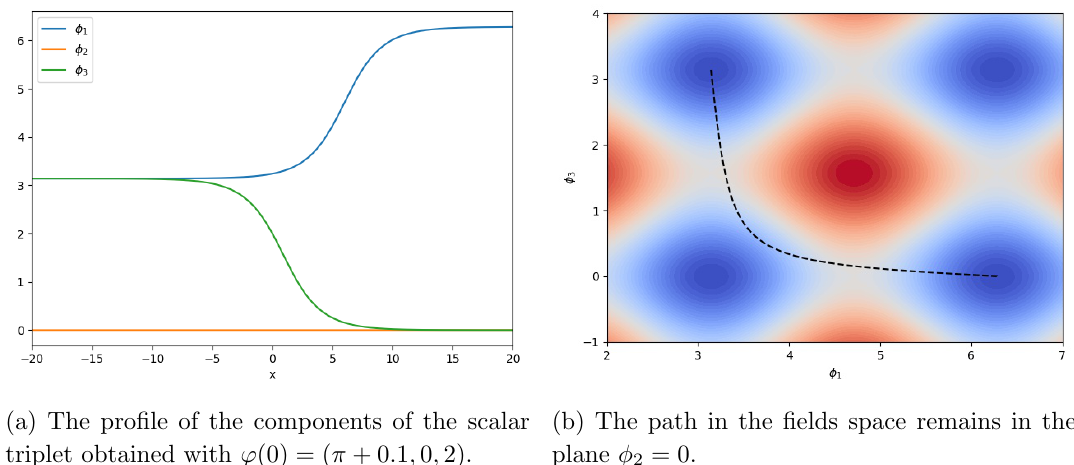
plane (cid:30) 2 = 0. Figure 13. For (cid:30) 2 = an integer multiple of 2 (cid:25) the BPS equations become the equations of two independent sine-Gordon models for the components (cid:30) 1 and (cid:30) 3 of the scalar triplet.